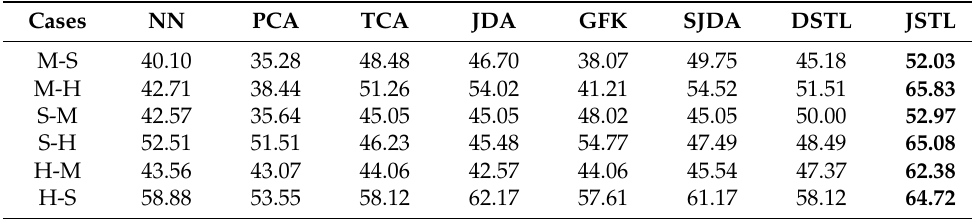
Table 5. Accuracy (%) of different methods under six